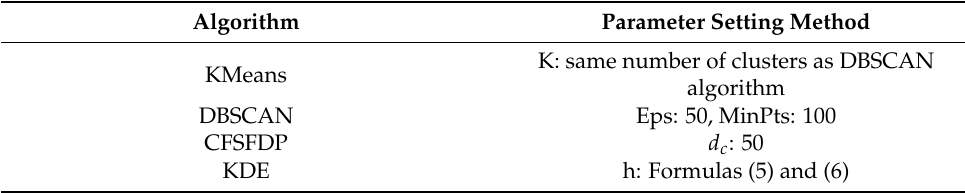
Table 4. The optimal parameters of each algorithm in the discovery of hotspots.